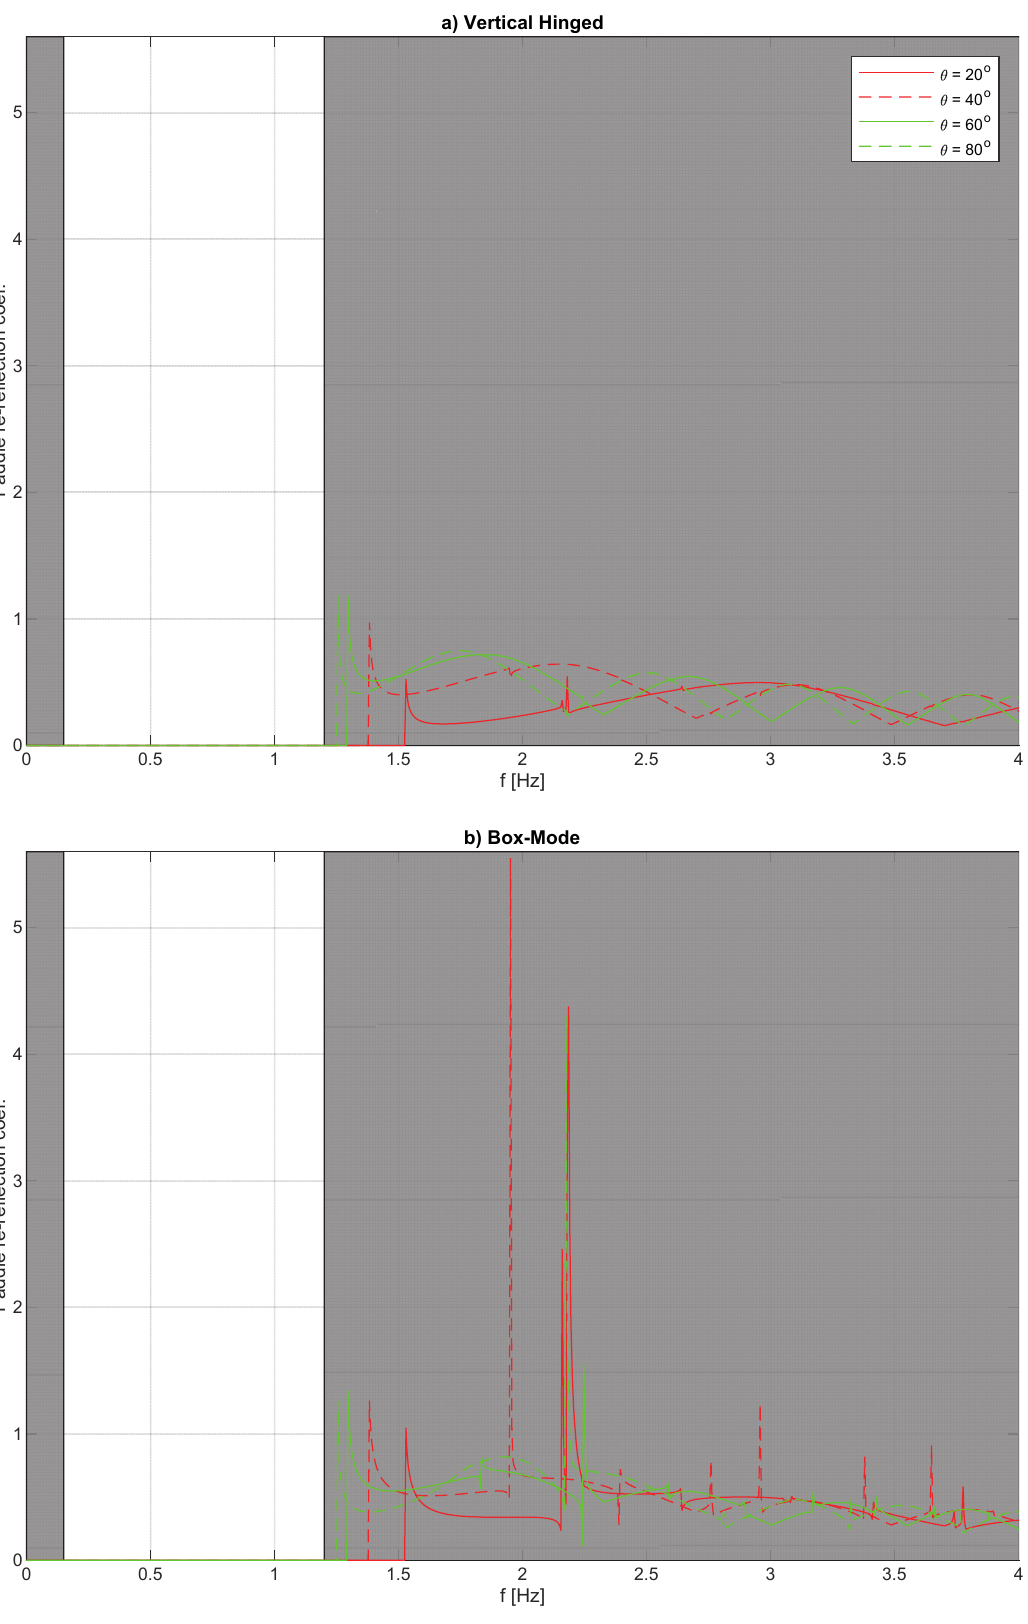
Figure 5. Performance curves in terms of paddle reflection coefficient for the p -value different from unity leading to the highest reflection as a function of frequency and obliquity of the wave to be absorbed. The case is identical to that studied in Figure 3. ( a ) Vertical hinged pistons with segment widths of l p = 0.5 m.; ( b ) Box-mode pistons also with l p = 0.5 m.